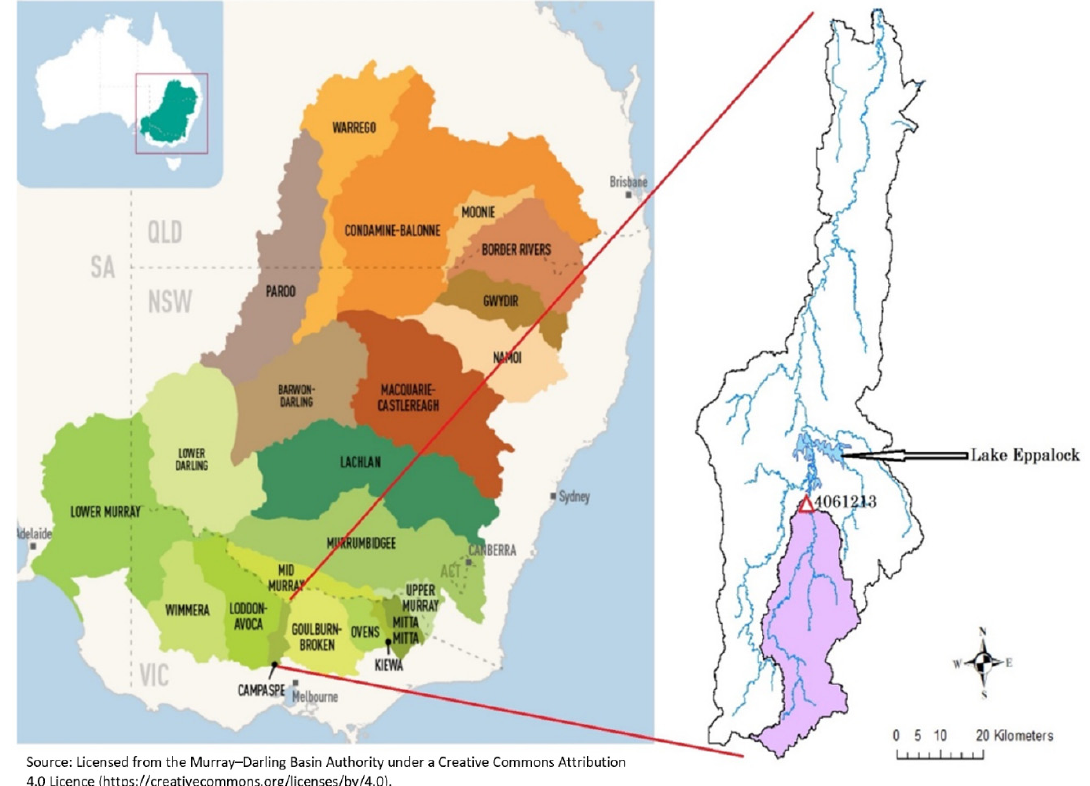
Figure 1. Location of the study area (adopted from MDBA [20]).